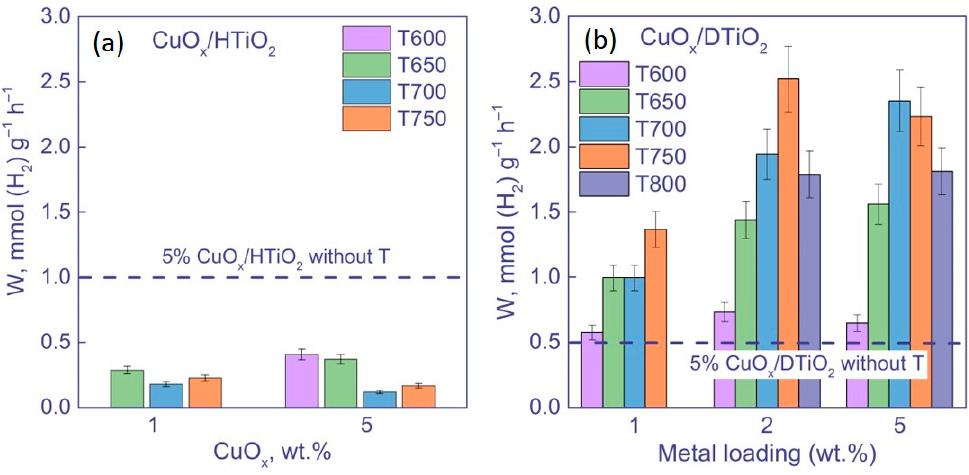
Figure 8. Rates of H 2 evolution over ( a ) CuO x /HTiO 2 and ( b ) CuO x /DTiO 2 . Conditions: m(cat.) = 50 mg, V = 100 mL, C 0 (glycerol) = 0.38 M, λ = 381 nm.